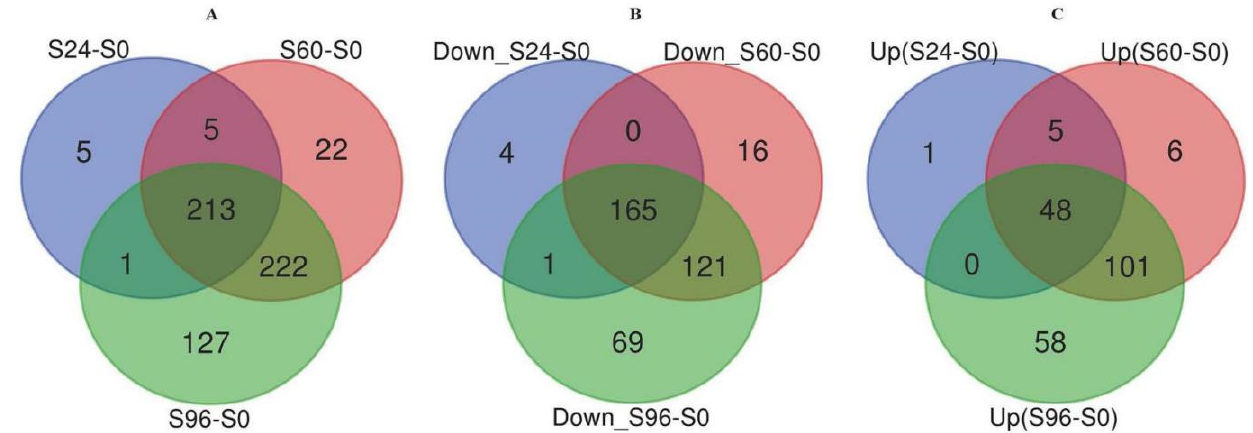
Figure 2. ( A – C ) Volcano plots showing DEPs in V. volvacea S24–S0, S60–S0, and S96–S0. Dots highlighted in red (FC ≥ 1.5) and green (FC ≤ 2/3) indicate proteins that exhibited significantly different expression levels ( p ≤ 0.05).